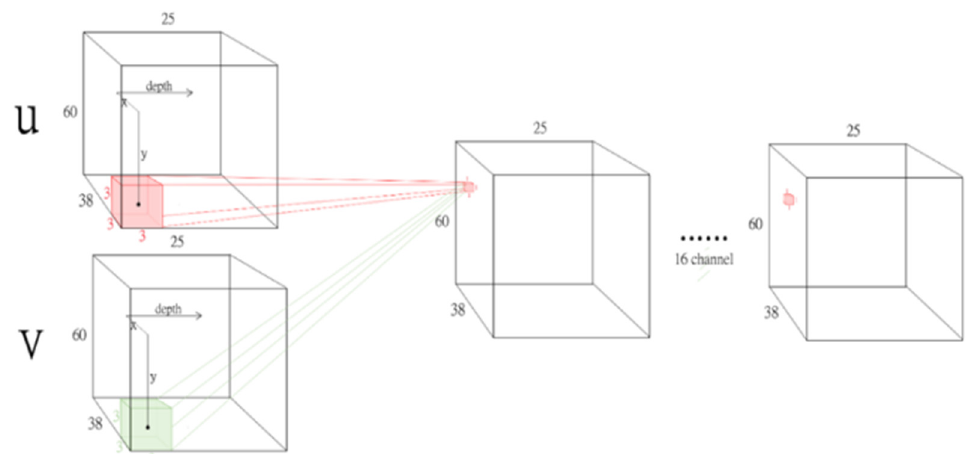
Figure 7. 3D convolution